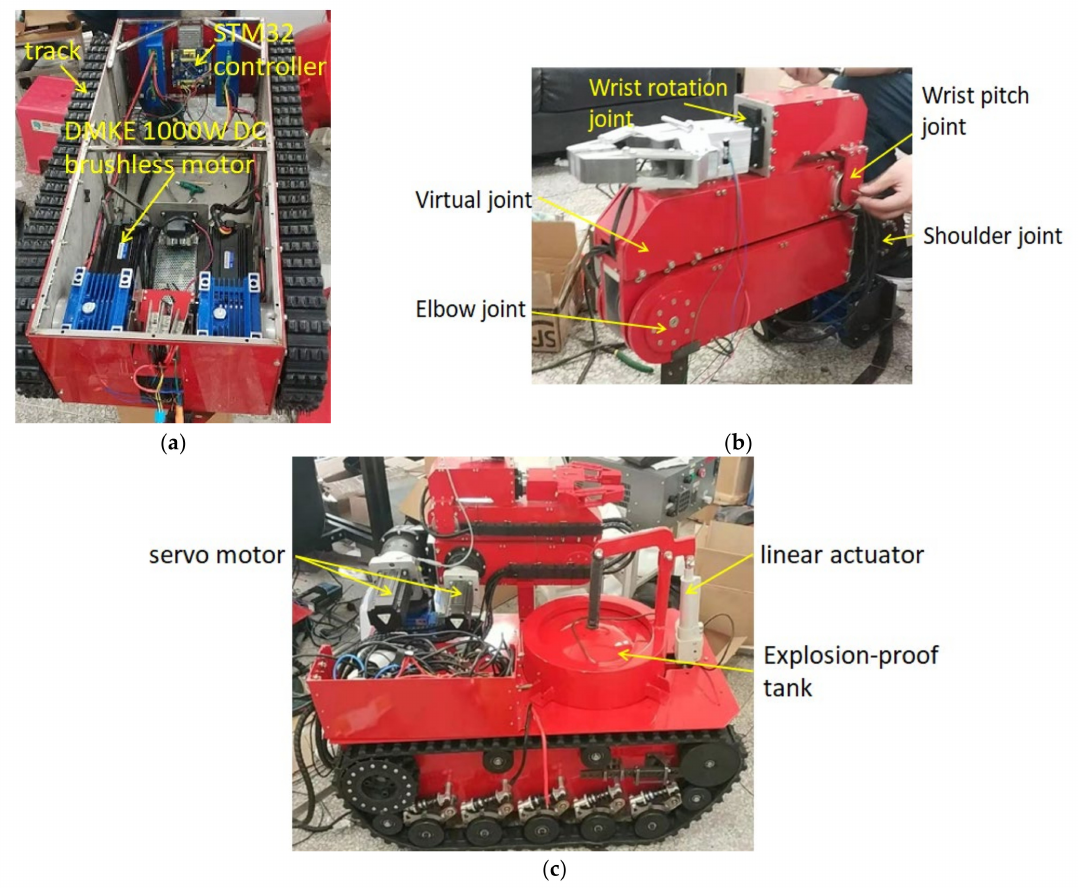
Figure 9. Construction process of experimental prototype: ( a ) Electrical components of mobile sites; ( b ) Components of mechanical arm; ( c ) Other components of EOD